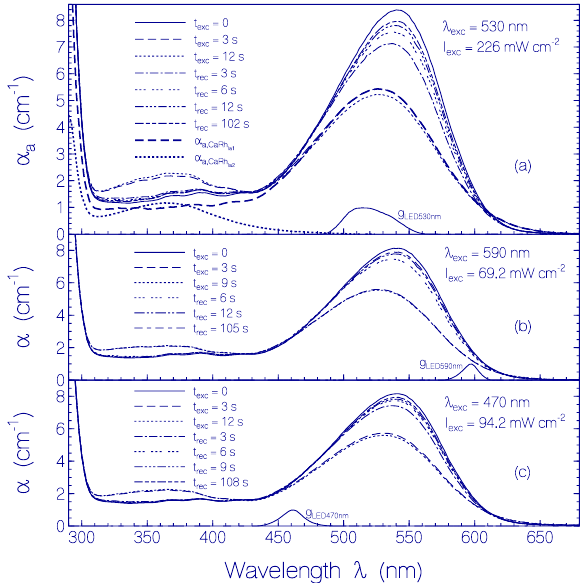
Figure 7. Photocycle behavior of CaRh. Absorption or attenuation coefficient spectra of a CaRh sample in pH 7.3 HEPES/MOPS buffer are shown before excitation ( t exc = 0 s), during excitation, and after excitation switch-off. ( a ) Excitation with Thorlabs LED 530 nm. Entrance excitation intensity I exc = 226 mW cm −2 . g LED530nm ( λ ) = S LED530nm ( λ )/S LED530nm ( λ max ) is the spectral distribution of the excitation light source. The thick dashed curve shows the separated absorption coefficient contribution α a , CaRh of CaRh la1 at t exc = 3 s. The thick dotted curve shows the separated absorption coefficient contribution α a , CaRh of CaRh la2 at t exc = 3 s; ( b ) Excitation with Thorlabs LED 590 nm. I exc = 69.2 mW cm − 2 and ( c ) Excitation with Thorlabs LED 470 nm. I exc = 94.2 mW cm − 2